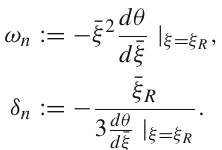
Fig. 1 Plots of the exact solutions for the case n = 1. The dashed curve represents the solution θ = sin ξ ξ of the standard equation while the continuous curve is the solution of the Palatini one, θ = 15 − ξ 2 with α = 3 / 4. The solution for n = 0, which is the same for both cases, is given by the dotted